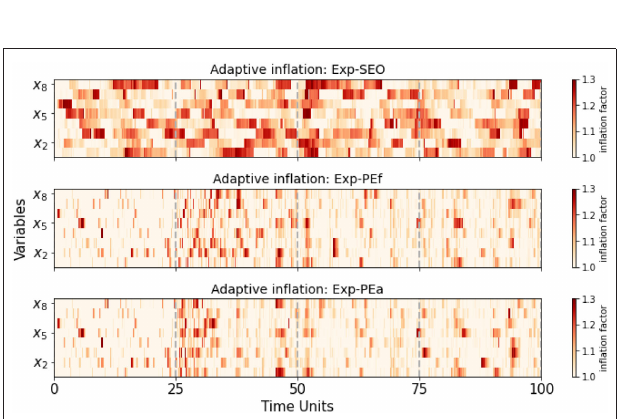
FIGURE 3 | The inflation factors derived from a spatially and temporally varying adaptive inflation method for experiments Exp-SEO (A) , Exp-PEf (B) , and Exp-PEa (C) .